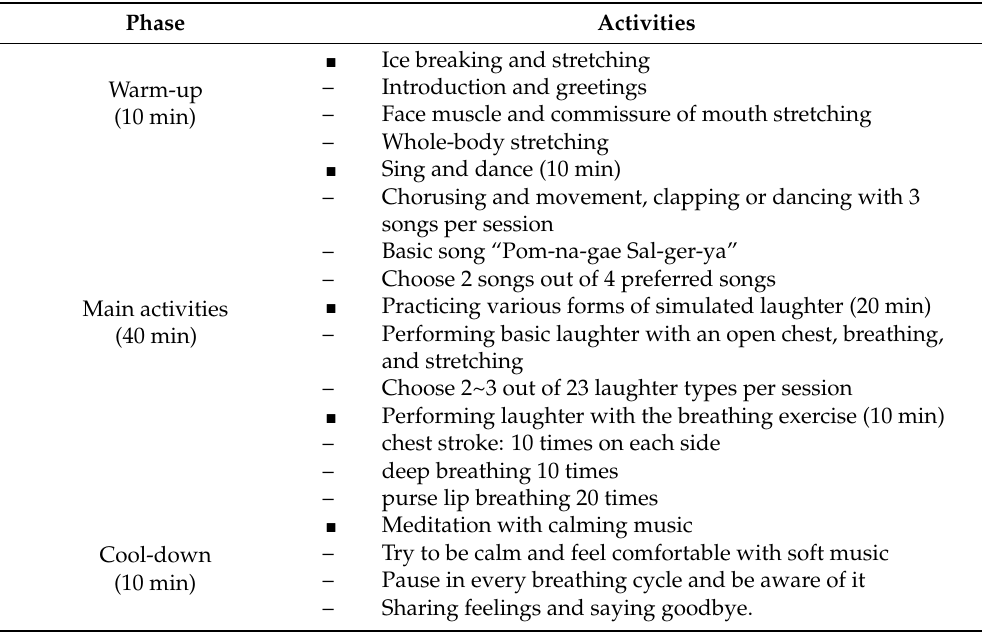
Table 1. Simulated laughter therapy for hospitalized patients with pulmonary